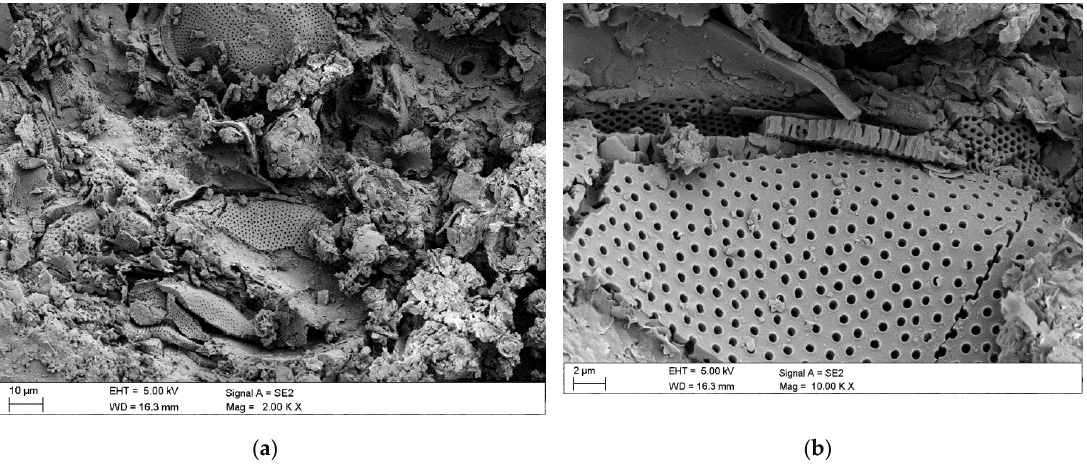
Figure 9. SEM images of microstructure and nanostructure of diatomieaus earth from the Jawornik deposit. ( a ) View of a raw diatomaceous earth sample, ( b ) close-up of the porous structure of a single frustule.